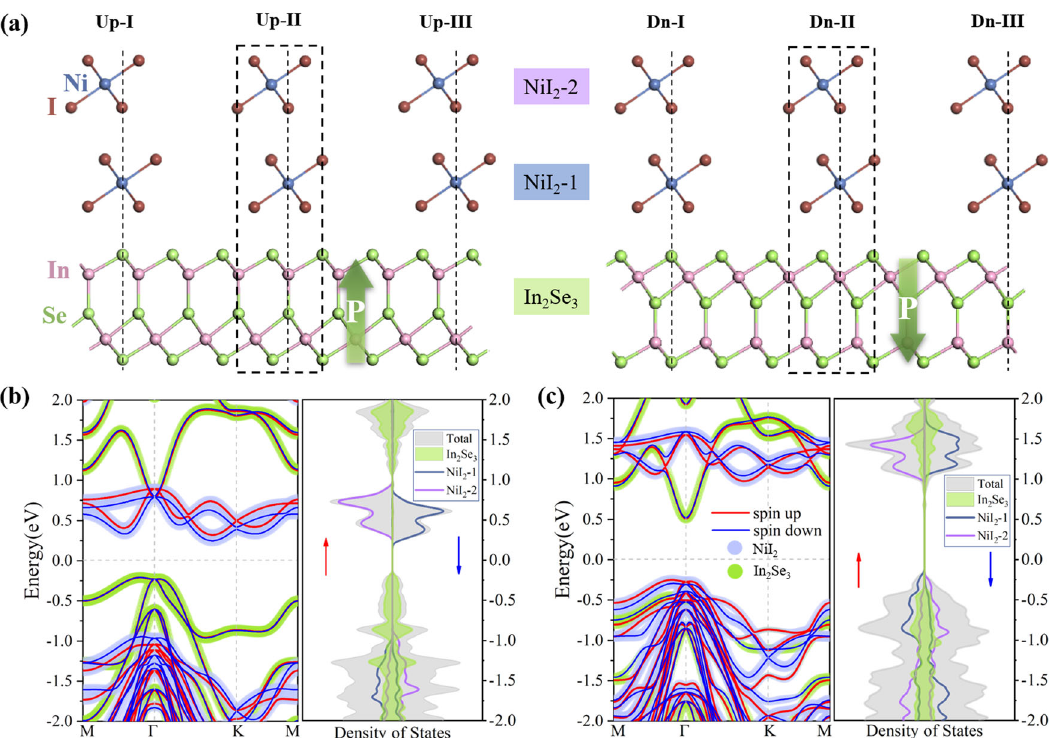
Fig. 2 Basic properties of bi-NiI 2 /In 2 Se 3 heterostructure. a Structural diagram of different stacking patterns for bi-NiI 2 /In 2 Se 3 heterostructure in the P ↑ and P ↓ con fi gurations. b , c Calculated band structures and DOS of bi-NiI 2 /In 2 Se 3 heterostructure in the P ↑ and P ↓ con fi gurations, respectively. The red and blue lines in the band structure represent spin-up and spin-down states,